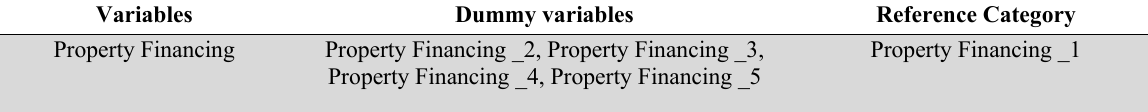
Multiple Ordinal Regression Analysis Model